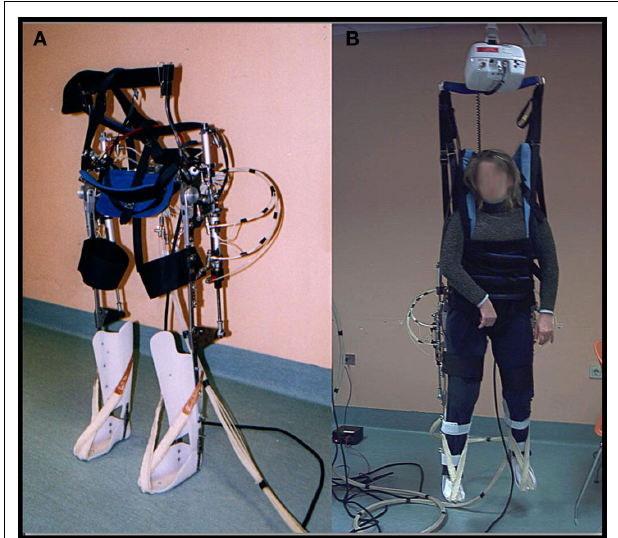
FIGURE 1 |Active RGO used for training, alone (A) and worn by subject (B).